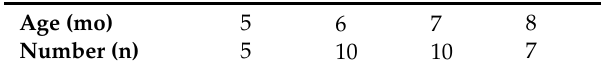
Table 1. Number of animals (n = 32) per age group